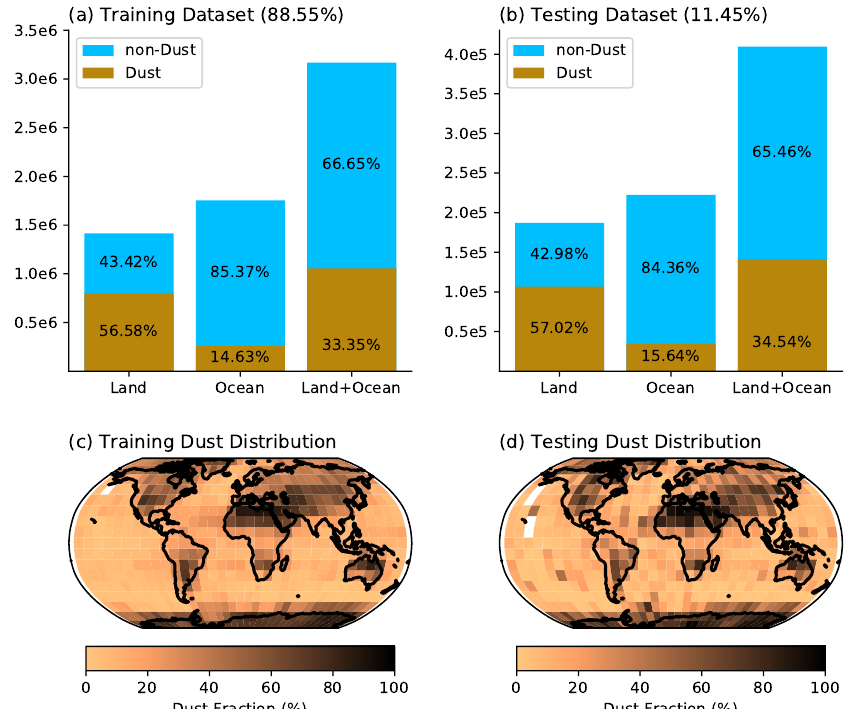
Figure 2. ( a , b ) Distribution of clear sky and dust over land and ocean, for both training and testing data. ( c , d ) distribution of dust for training and testing data. Spatial distribution is averaged with 5 × 5 latitude, longitude grid